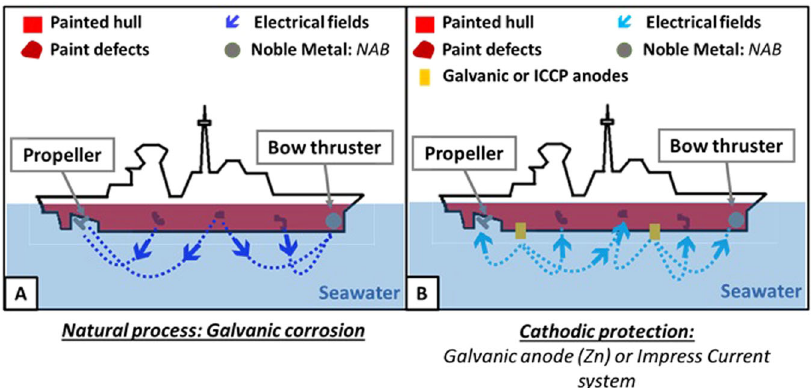
Fig. 1 Illustration of the major causes of electrical signature of ship ’ s hull. There are two cases, the natural and spontaneous phenomenon, the galvanic coupling illustrated in ( A ), and the process of cathodic protection illustrated in ( B ) with the case of Impress Current Cathodic Protection system (ICCP) 4 .